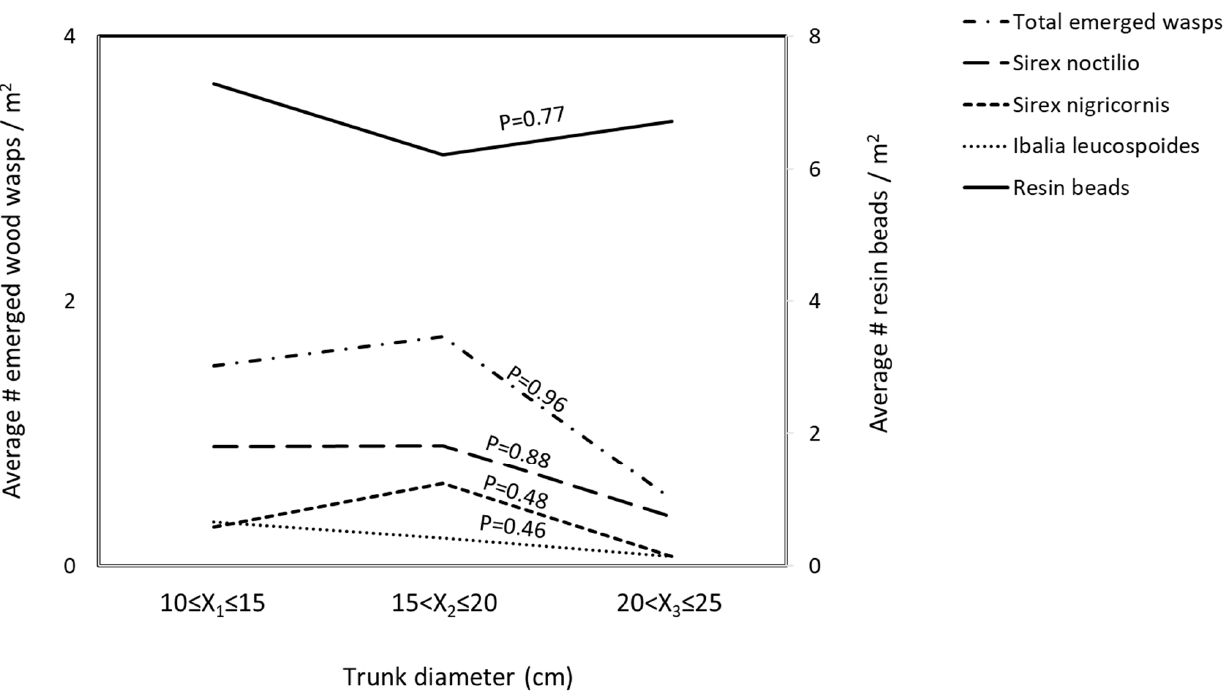
Figure 2. The density of resin beads and emerged wood wasps per square meter on log sections with heights of 1.5, 3, 4.5, 6, and 7.5 m above ground. The height was significant only for resin bead density ( X 2 = 21.63, p < 0.01), not for the emergence of Sirex noctilio ( p = 0.28), S. nigricornis ( p = 0.08), and Ibalia leucospoides ( p = 0.50).